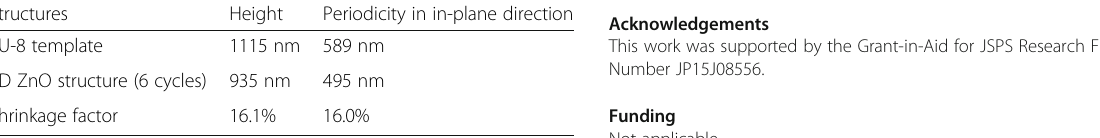
Table 2 Average values of structure height and periodicity in in-plane direction and the shrinkage factors